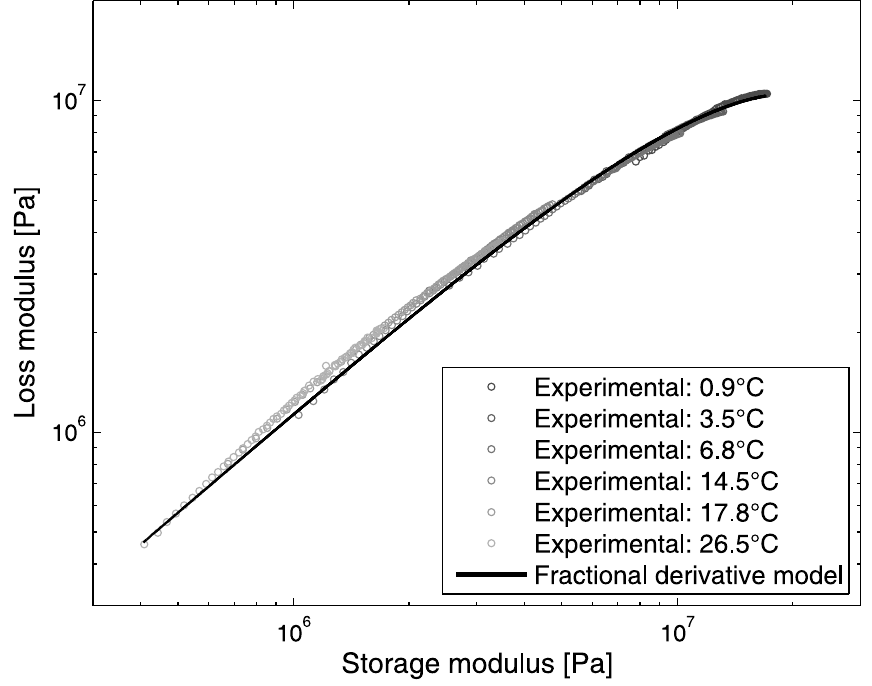
Fig. 10. Wicket plot for the frequency-temperature fractional derivative